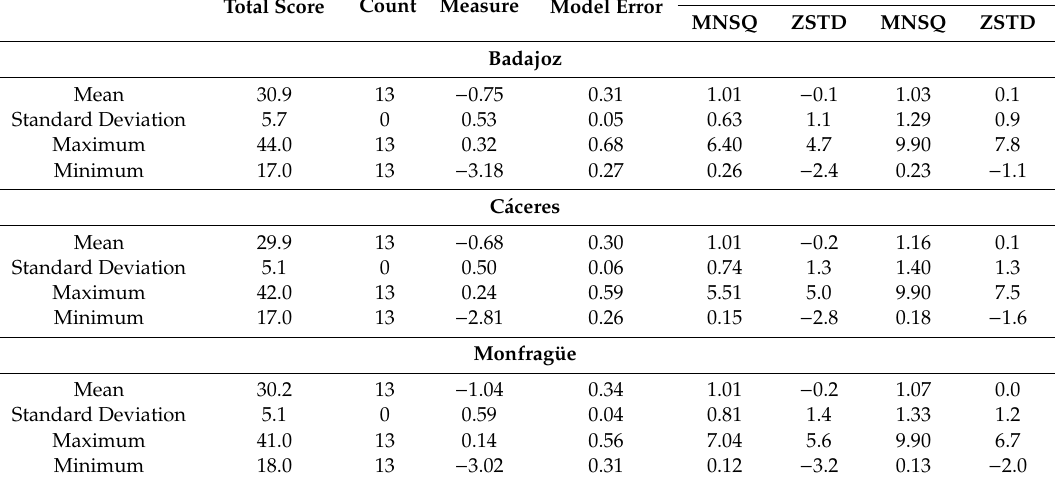
Table 2. Overall model fit information; summary of all 365 days in 2016 for the three locations: sum of points of the common scale (total score), days or items taken into account (count), logit position of the days, and items along the straight line that represents the latent variable, atmospheric pollution (measure), and standard error of measurement (model error). Infit and outfit MNSQ are mean-square fit statistics to verify if items fit the model; infit and outfit ZSTD are standardized fit statistics to verify if items fit the